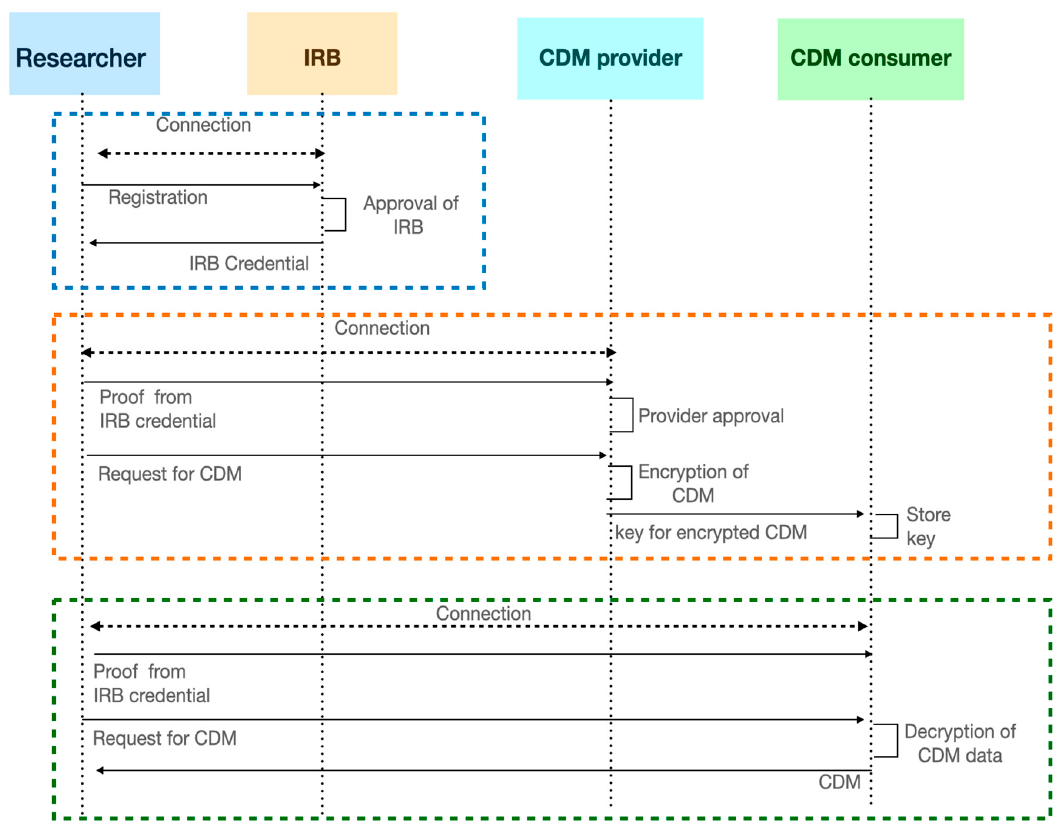
Figure 6. The process of issuing and verifying credential when handling CDM.